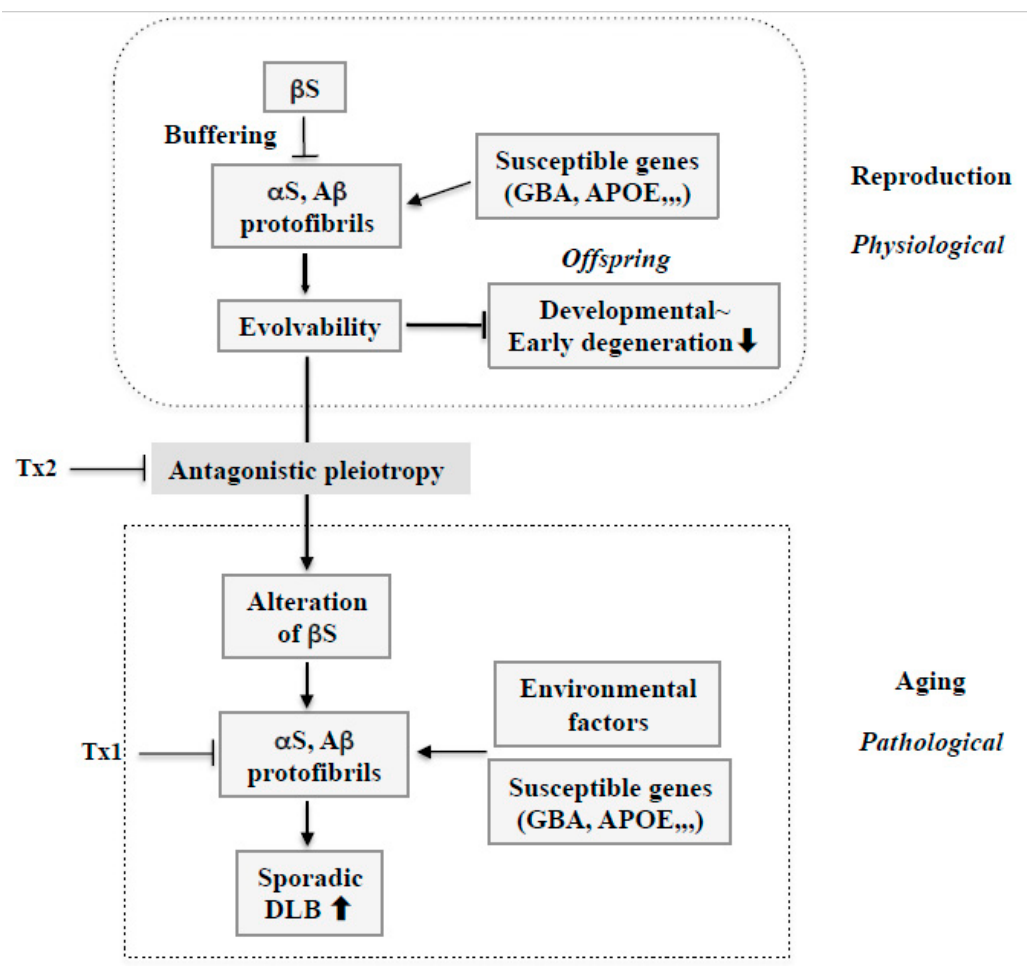
Figure 5. Therapy strategy against sporadic DLB based on amyloidogenic evolvability. During reproduction, stress information may be delivered by protofibrils of APs, including α S and A β , from parents to offspring. Therefore, increased evolvability of APs in reproduction may be beneficial for the offspring’s brain to avoid developmentally early degenerative diseases. Evolvability of APs, however, becomes detrimental through the antagonistic pleiotropy mechanism in aging. β S might play an important role as a buffer for evolvability of APs. However, β S might be altered through the antagonistic pleiotropy mechanism in aging and stimulate formation of protofibrils of APs. In this context, susceptible genes, such as GBA and APOE, might be beneficial for evolvability in reproduction, but may stimulate the neurotoxic protofibrils formation of APs combined with environmental factors, leading to neurodegeneration in aging. Based on such a view, at least two therapy strategies against sporadic DLB could be considered. First, given the importance of APs protofibrils in neurodegeneration in aging, dose-reduction therapy should be considered for APs, including α S and A β (Tx1). Second, neurodegeneration by APs protofibrils in aging might be promoted by the antagonistic pleiotropy mechanism. Therefore, this process could be a therapeutic target (Tx2).